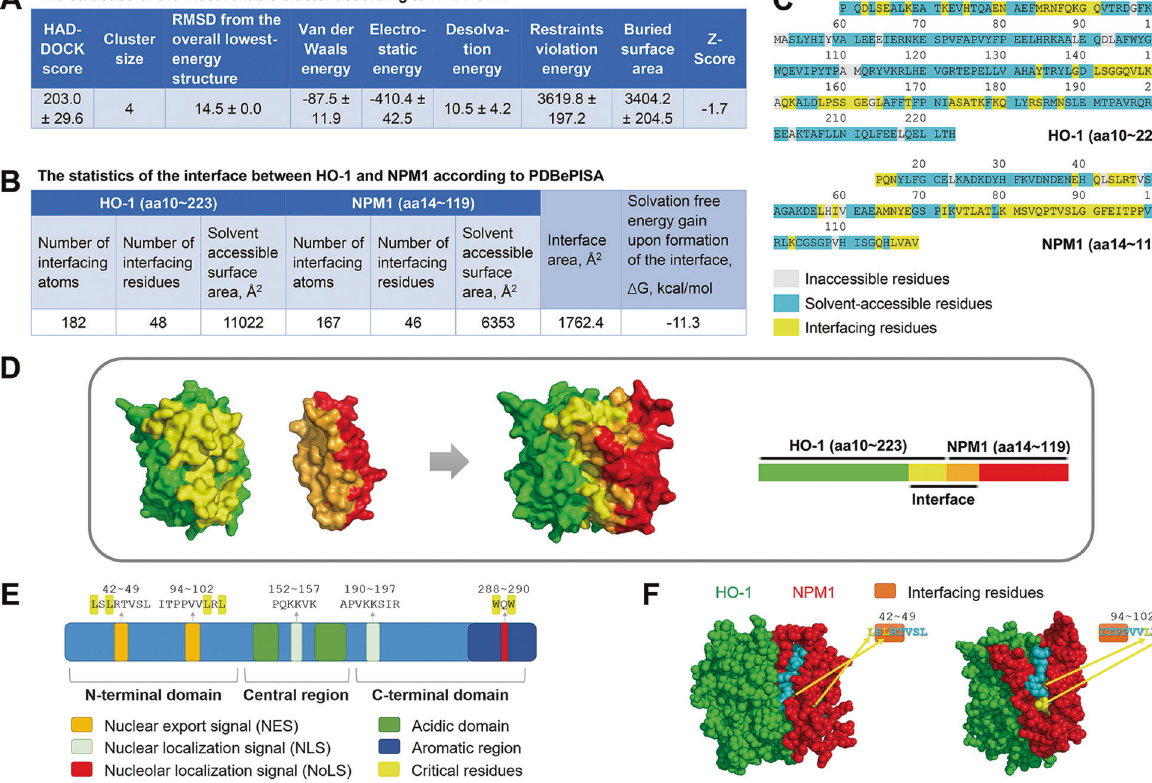
Fig. 7 HO-1-NPM1 docking statistics and visual crystal structure. A Statistics of the top 1 cluster of HO-1-NPM1 complex according to HADDOCK. B Statistics of interface between HO-1 and N-terminal NPM1 according to PDBePISA. C Speci fi c interfacing residues were demonstrated. D HO-1-NPM1 complex was visualized by PyMOL software. E Structure and functional domains of NPM1. F 3D structure information of interface between HO-1 and N-terminal